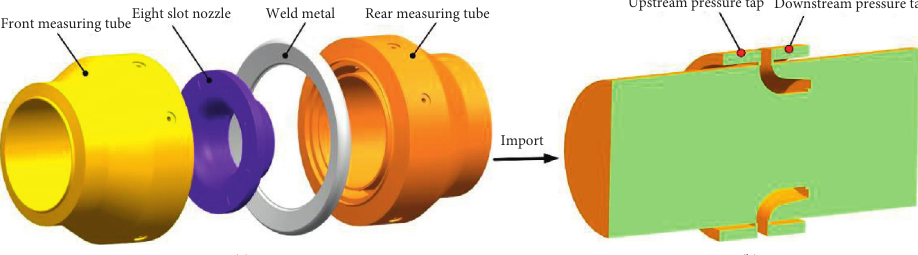
Figure 6: Schematic diagram of solid structure and flow field calculation domain. (a) Solid structure domain. (b) Half-section view of flow field.